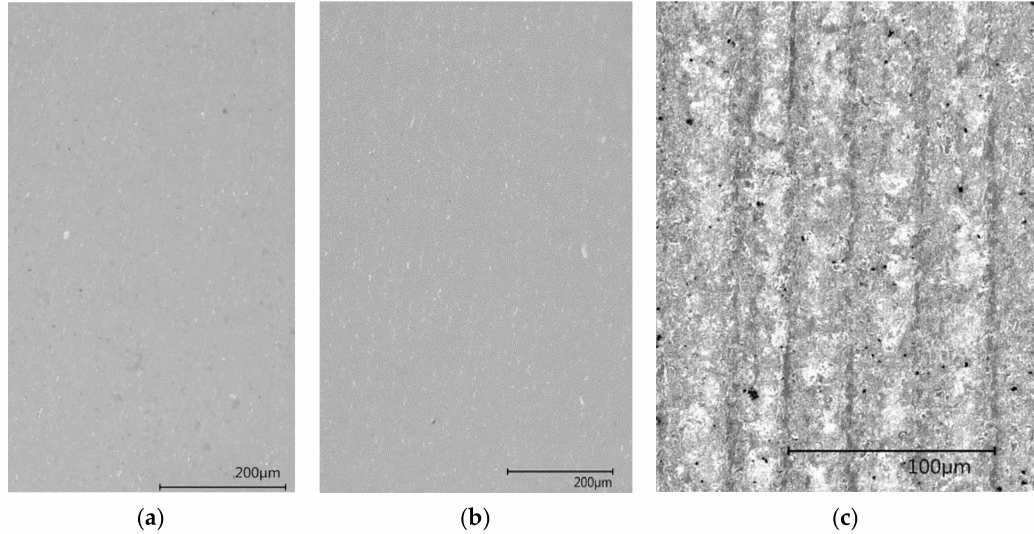
Figure 10. Digital microscopy images reveal homogenous structures for group A samples ( a ) and group B samples ( b ). Resin layers separated by ink layers are visible for group C samples ( c ). Aside from small defects arising from the printing process, the structure of group A and B samples appears homogenous with no indication of a layer-wise build-up. In group C samples, single printing layers are visible. The cross-section of a group C sample is depicted in Figure 11. Thin darker lines represent ink layers while resin layers appear in brighter